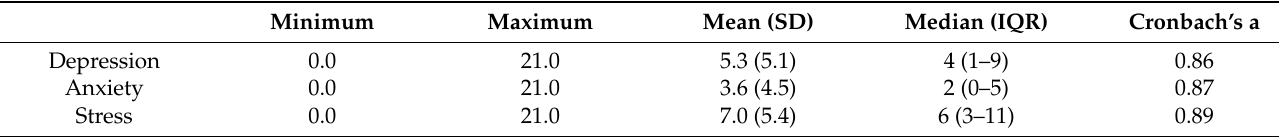
Table 3. Description of DASS-21